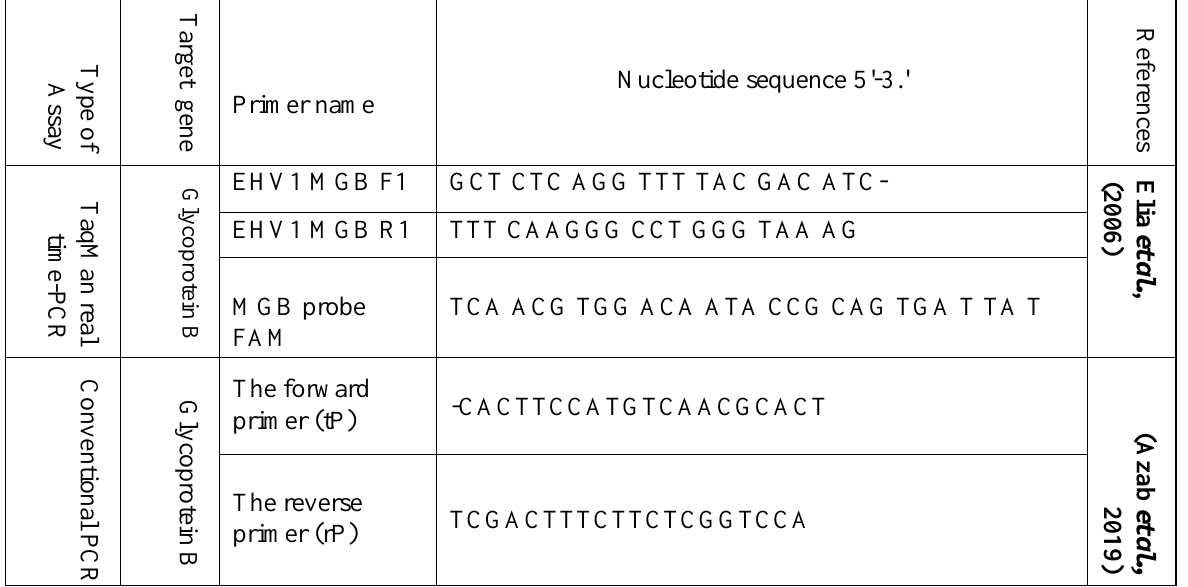
Nucleotide sequence 5'-3.'